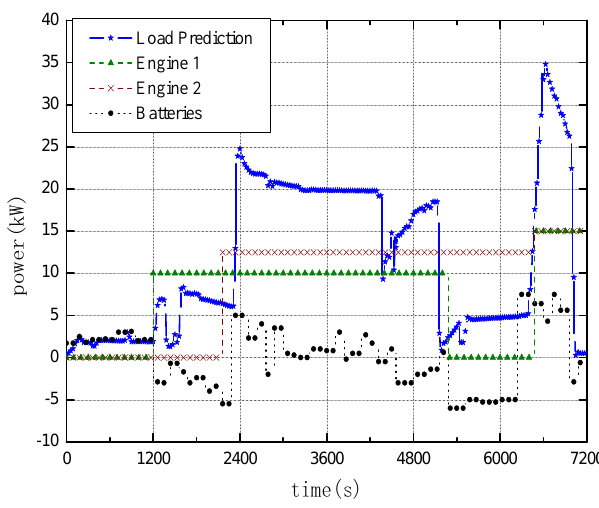
Figure 6. Power distribution based on fuzzy logic